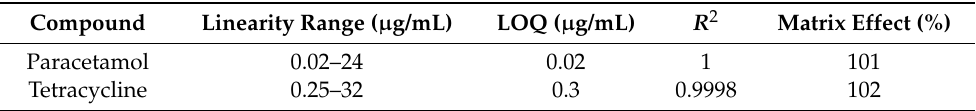
Table A2. Linearity of paracetamol and tetracycline; observed matrix effects. LOQ: lower limit of